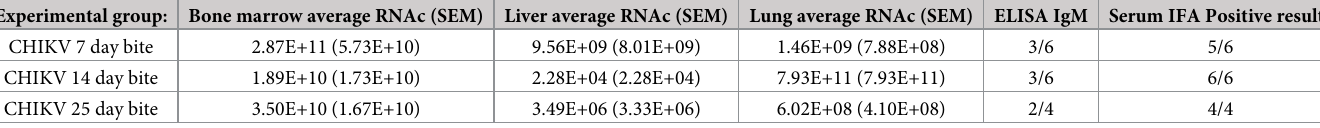
Table 1. CHIKV is detected in various humanized mouse tissues after infection via mosquito